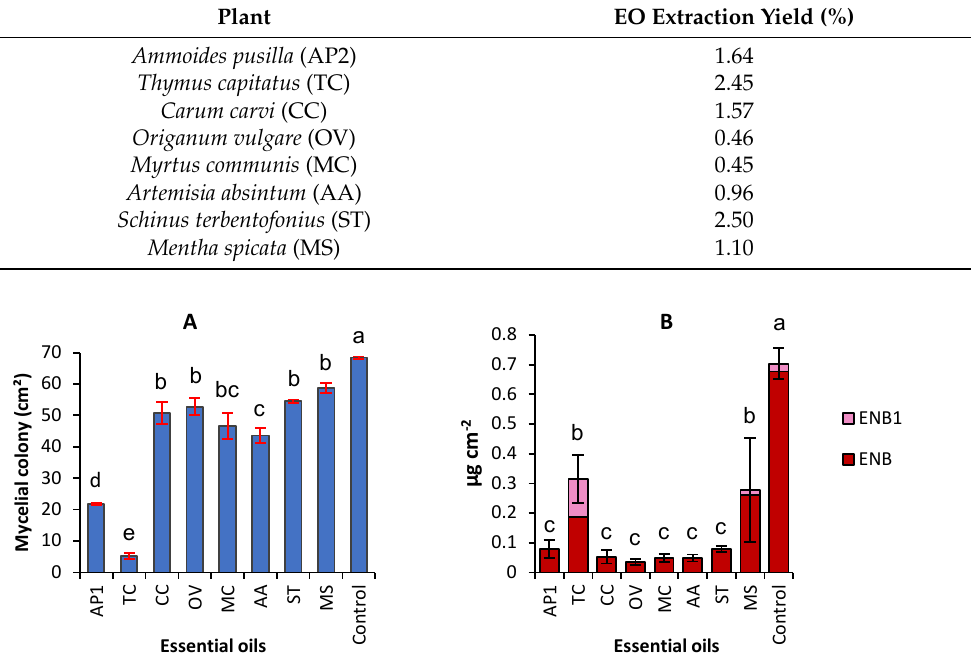
Figure 1. Effect of essential oils extracted from eight Tunisian plants used at 0.1 µ L · mL − 1 on the mycelial growth ( A ) and the accumulation of enniatins (ENNs) ( B ) by F. avenaceum . Values are means of 3 replicates. Error bars are ± standard deviation. Means with the same lowercase letter are not significantly different ( p < 0.05). ENB1 = enniatin B1, ENB = enniatin B. AP1 = Ammoides pusilla , TC = Thymus capitatus , CC = Carum carvi, OV = Origanum vulgare , MC = Myrtus communis , AA = Artemisia absintum , ST = Schinus terbentofonius , MS = Mentha spicata